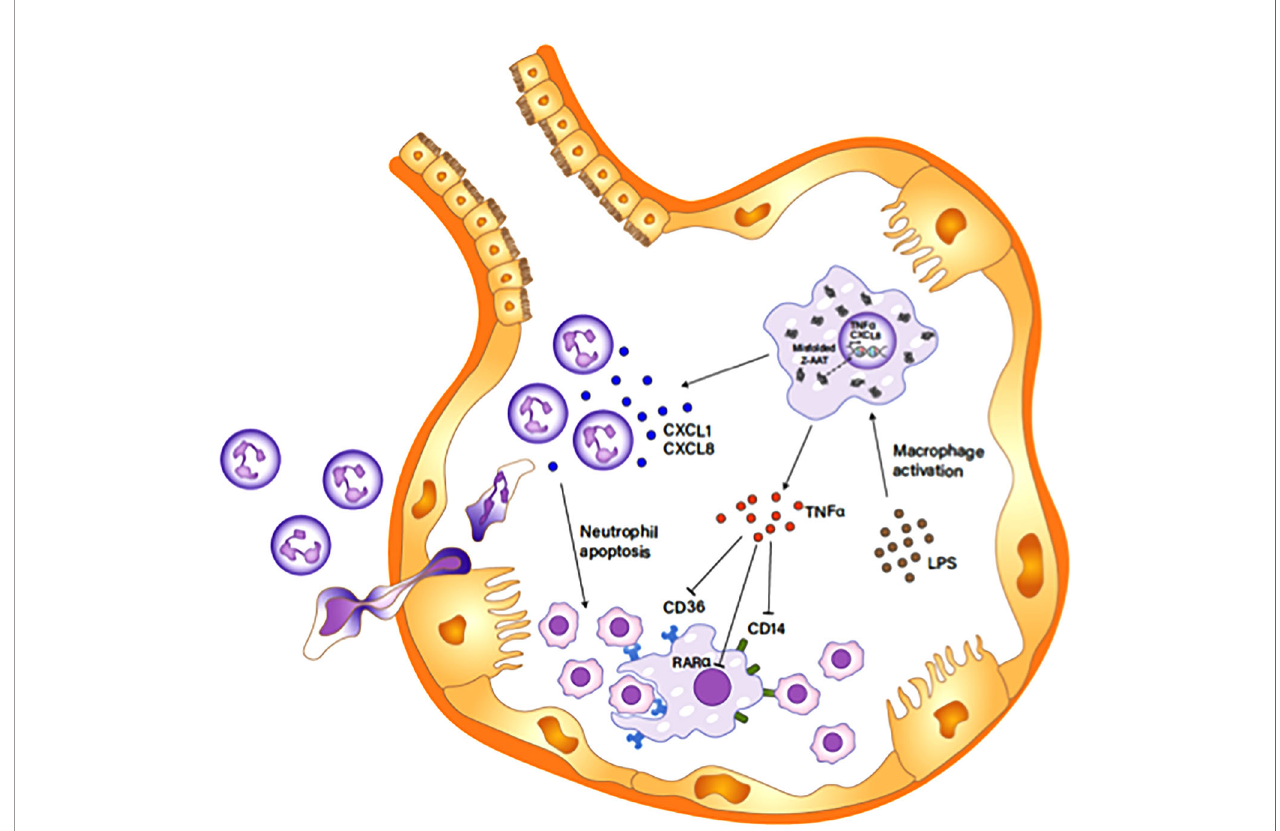
FIGURE 10 | Z-AAT causing excessive neutrophil accumulation in the pulmonary alveolus. Unfolded Z-AAT induces the expressions of CXCL-8 and TNF a in LPS- stimulated macrophages. The increased level of the chemotactic factor accelerates neutrophil in fi ltration to the pulmonary alveolus. LPS-induced TNF a expression inhibits the expression of CD14, CD36, and RAR a that are important in macrophage efferocytosis of apoptotic cells, delaying the clearance of apoptotic neutrophils by macrophages. The impaired clearance of neutrophils aggravates and prolongs the neutrophil in fl ux in the pulmonary